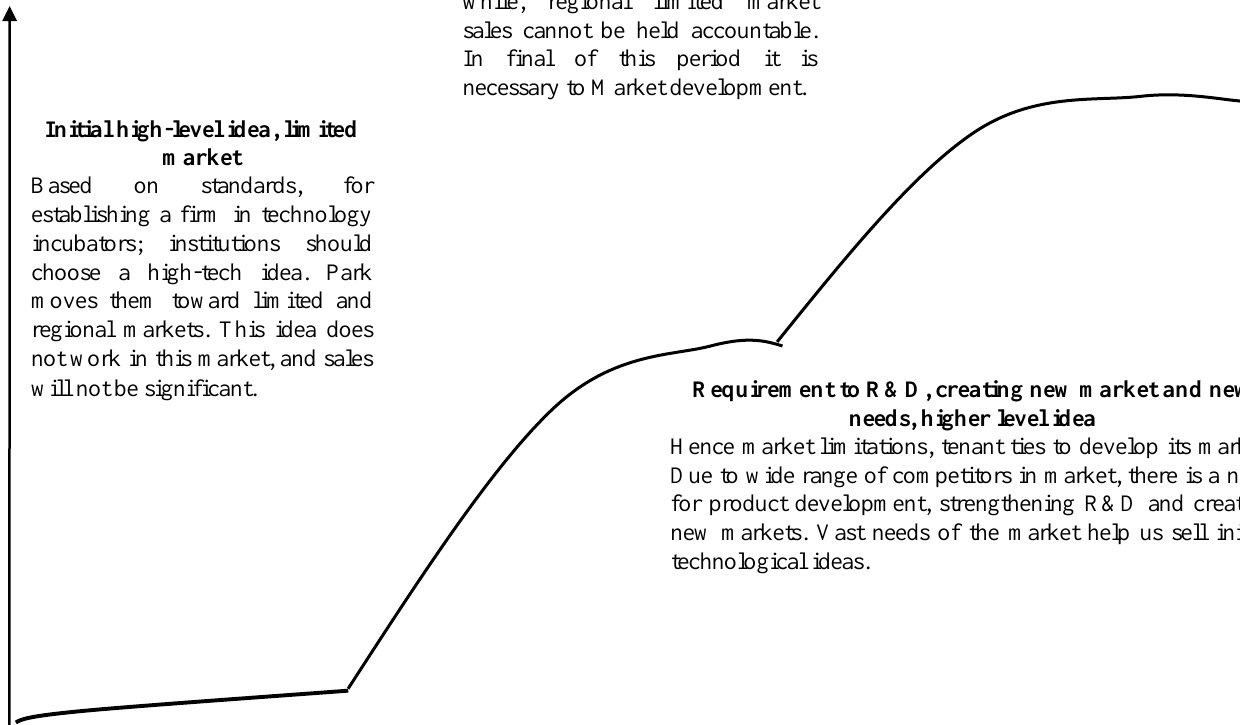
Figure 3. Behavior over time Diagram for knowledge based